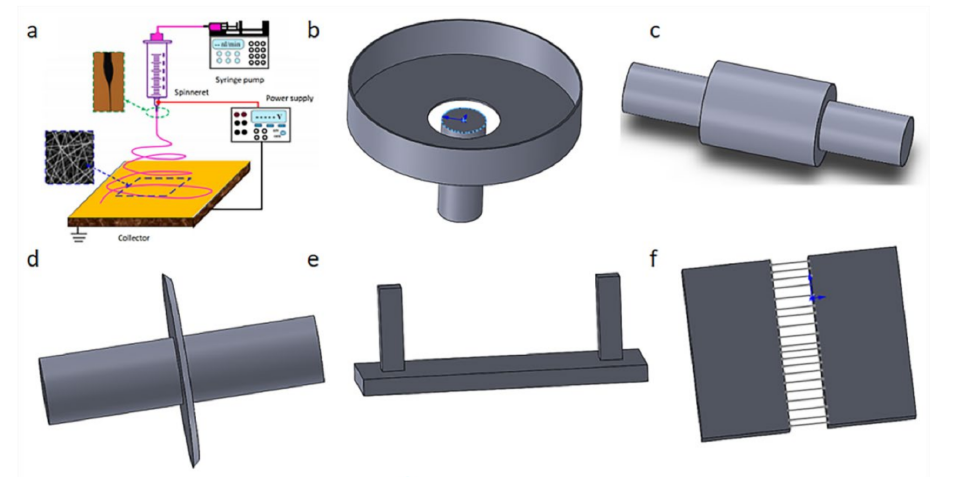
Figure 1. A typical electrospinning operation and different collector types. ( a ) Electrospinning principle diagram [8]; ( b ) water bath collector; ( c ) roller collector; ( d ) disc collector; ( e ) magnetized collector; ( f ) parallel plate electrode